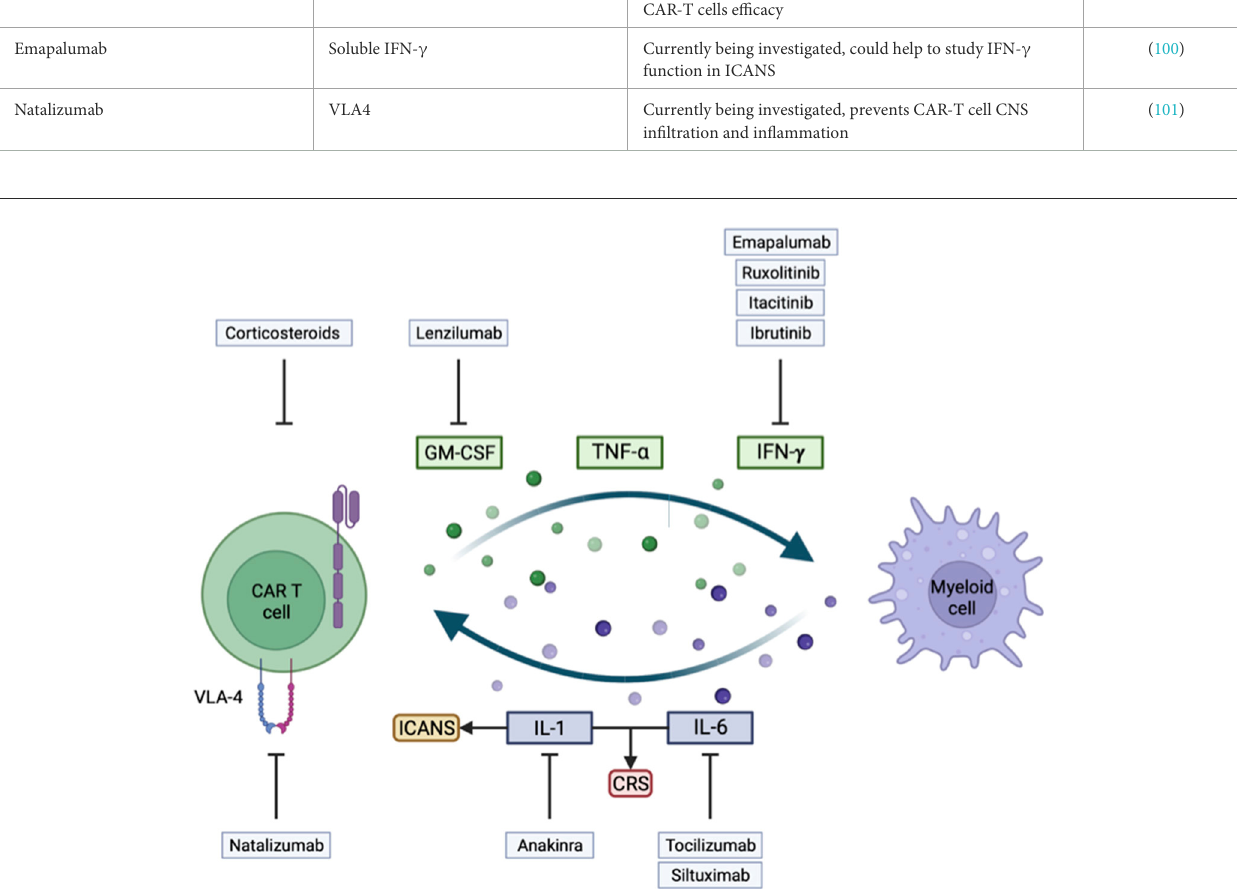
FIGURE1 Illustration of key mechanisms involved in the development of immune effector cell-associated neurotoxicity syndrome (ICANS) and cytokine release syndrome (CRS), and their corresponding treatment strategy.